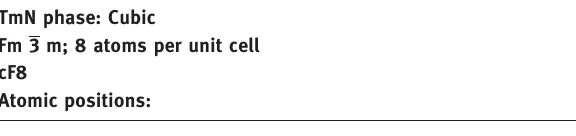
Table 1: Crystallographic data of the cubic TmN phase. TmN phase: Cubic